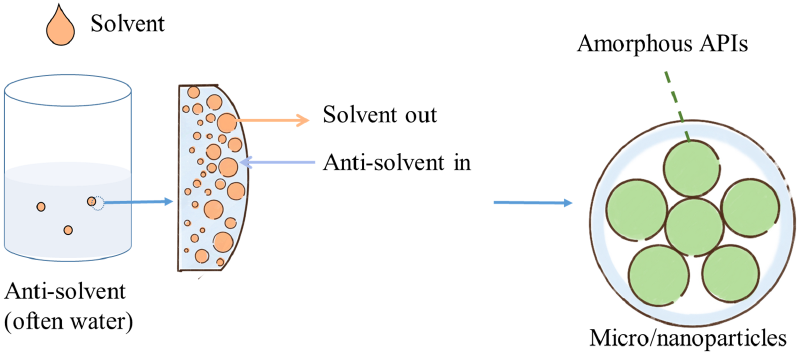
Figure 10. The mechanism of trapping amorphous APIs in nanoparticles via nanoprecipitation [96]